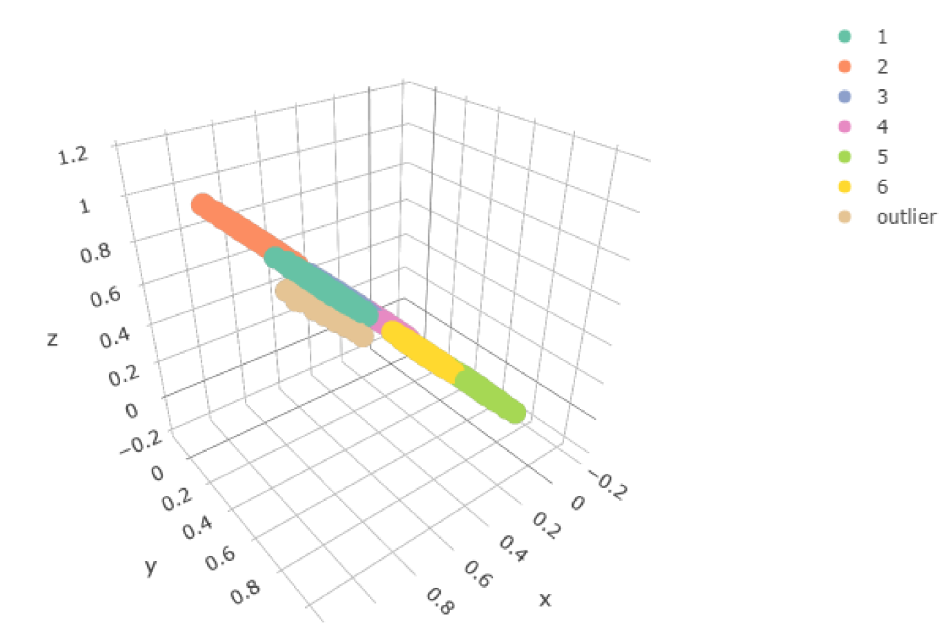
Figure 4. Population used in the experiment, x, y, z coordinates